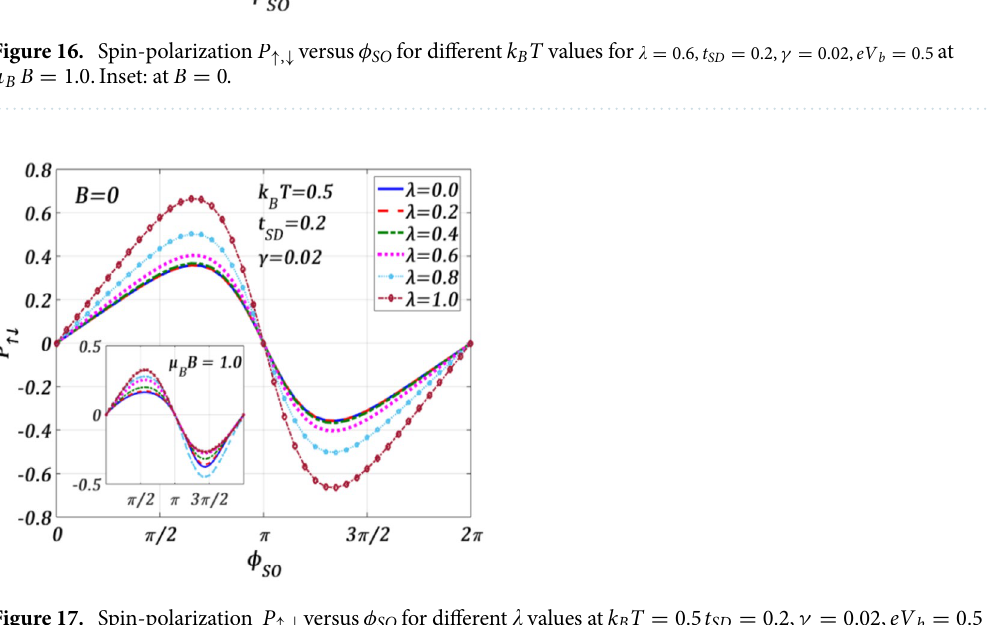
Figure 17. Spin-polarization P 0 . Inset: at µ B B for B =